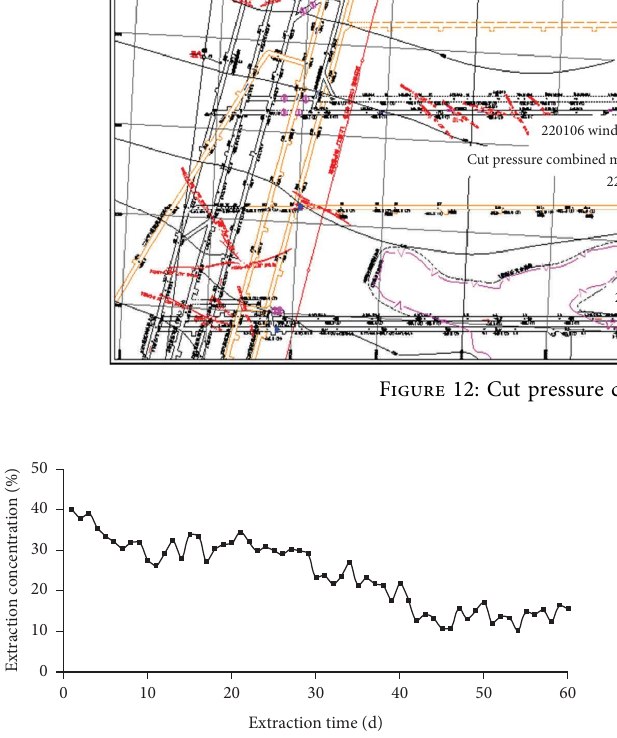
Figure 13: Change curve of extraction concentration.